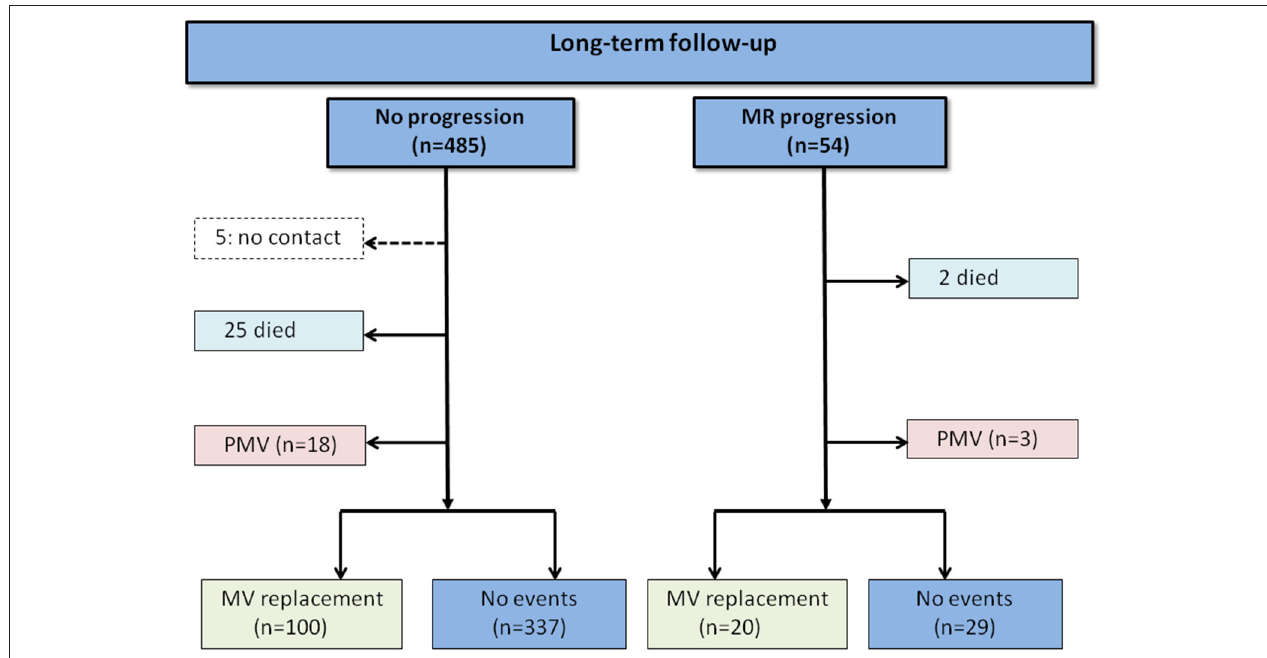
FIGURE 2 | Long-term follow-up of patients with rheumatic heart disease (RHD).